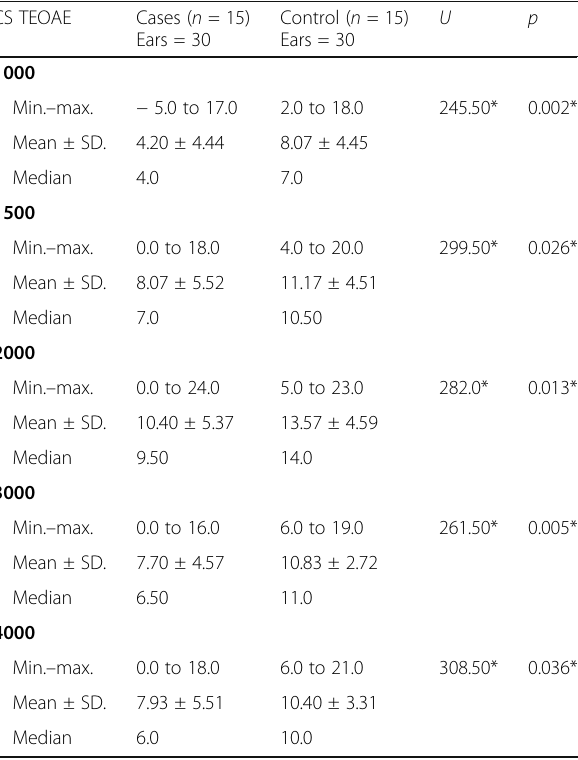
Table 5 Contralateral suppression of TEOAE SNR amplitudes (dB SPL) in tinnitus patients and control group